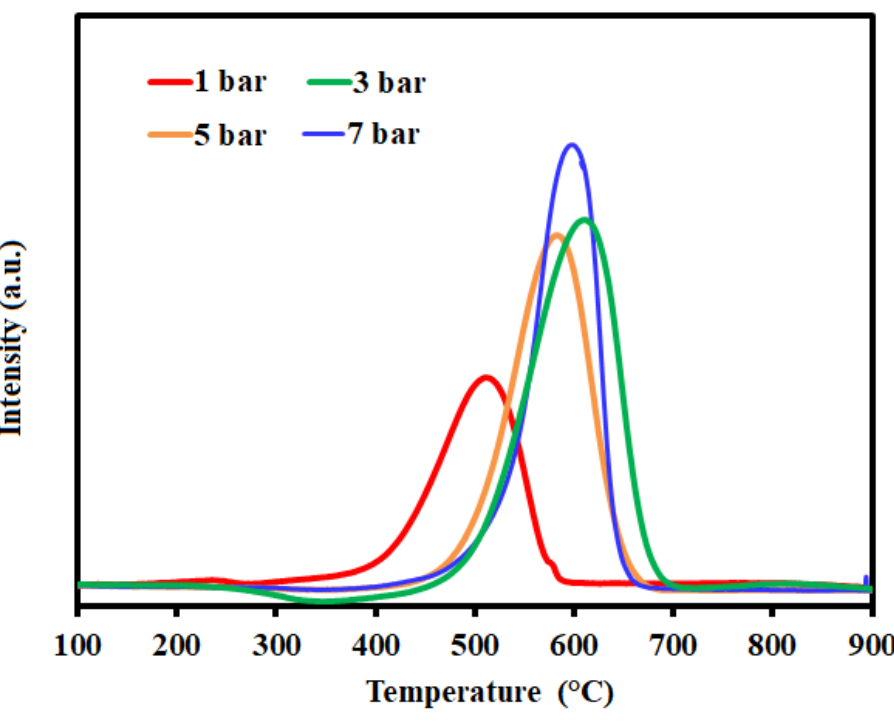
Figure 9. TPO of the used catalyst, calcined at 725 ° C, after 8 h reaction time in DRM at 700 °C.